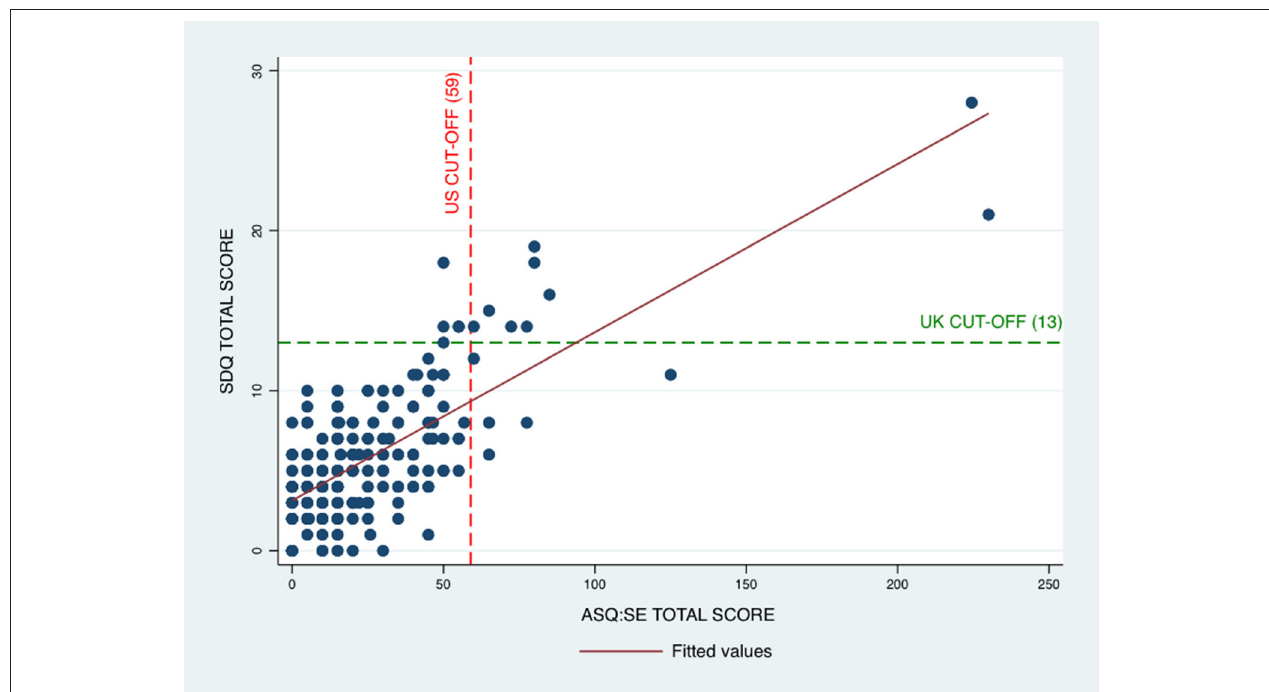
FIGURE 1 | The correlation between ASQ:SE and SDQ in a population-based study of 3-year olds. ASQ:SE, Ages and Stages Questionnaires: Social-Emotional for 36-month interval, first edition; SDQ, Strengths and Difficulties Questionnaire, 2–4 year version.